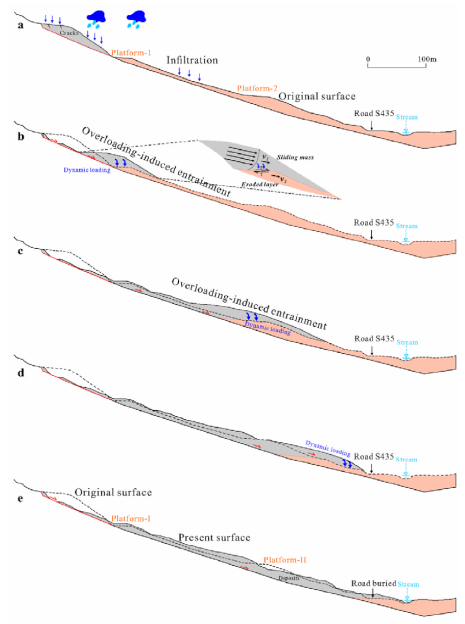
Figure 15. Mechanism of the ZHC landslide. ( a ). Initiation sliding occurred due to the heavy rainfall. ( b ). First entrainment sliding. ( c ). Second entrainment sliding and flow-like moving. ( d ). Third entrainment sliding. ( e ). Topography features after